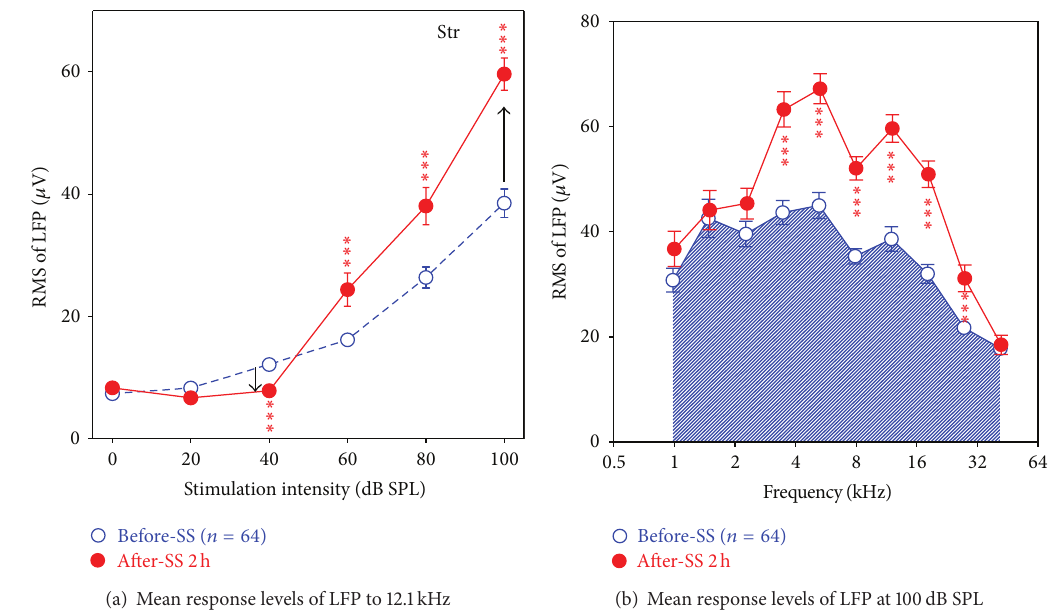
Figure 4: The effects of SS-injection on the tone-evoked LFP in the Str. (a) Mean RMSs of LFP ( 𝑛 = 64 ) to 12.1 kHz in a time window of 100ms as a function of stimulation level, showing increase of LFP amplitude at high stimulation levels but a reduction at low stimulation levels. (b) Mean RMSs of LFP ( 𝑛 = 64 ) at 100dB SPL as a function of stimulation frequency, showing significant enhancement at midfrequencies (3.5– 18.3 kHz). Acoustic stimulation: 50 ms tone bursts at different frequencies; treatment: SS (250 mg/kg, i.p.); the vertical bars are SEs and the ∗ ∗ ∗ means 𝑃 < 0.001 ; the arrows indicate increase and decrease of LFP